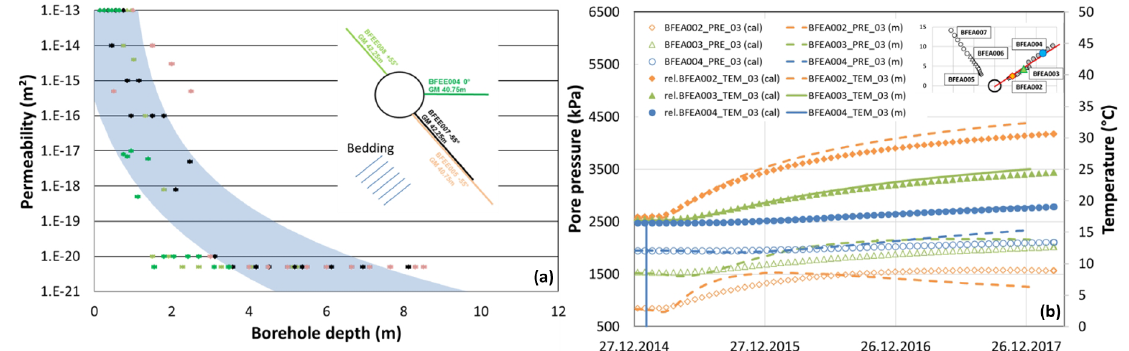
Figure 9. Permeability distribution around the FE-tunnel in the section without shotcrete ( a , after Shao et al., 2017a) and comparison between measured and modelled temperature and pore water pressure in the boreholes during the heating phase (b) .